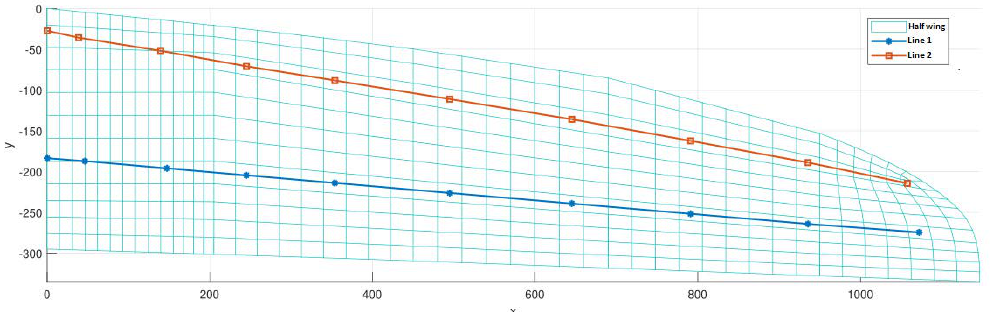
Figure 7. Half-wing with strain measuring lines on the upper panel for the application of the Ko’s Displacement Theory.